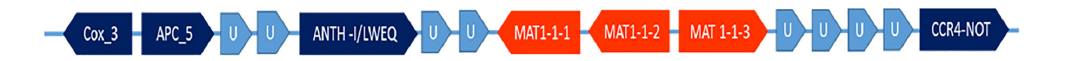
FIGURE 11 | Structure of the MA3 mating type locus and flanking regions. The mating type genes MAT-1-1, MAT 1-1-2 and MAT 1-1-3 were preceded by a putative cyclooxygenase 3 (COX3) gene (MA3T_15397), Anaphase-promoting complex subunit 5 (APC_5), ANTH/LWEQ gene containing a AP180 N-terminal homology domain containing gene (ANTH) and I/LWEQ domain homologous to SLA2. Putative MA3 specific genes with no known homologs (U) were found either side of the mating type